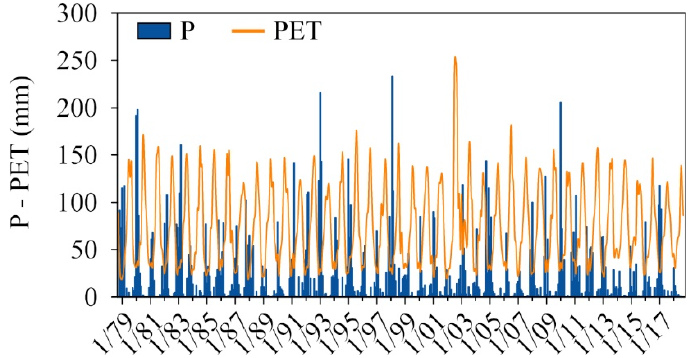
Figure 2. Monthly precipitation (P) and potential evapotranspiration (PET) from Agua Caliente (1979–2016) and Guadalupe Valley (2017–2018) weather stations, Baja California, Mexico. The x -axis indicates month/year. Table 1. Drought severity classification according to the Standardized Precipitation Index (SPI) modified from [7], applied to the classification of drought in the Guadalupe Valley Basin, Baja California, Mexico. Drought Classification SPI Normal (NOR) > − 0.5 Abnormally dry (AD) − 0.5 to − 0.8 Moderate drought (MD) − 0.8 to − 1.3 Severe drought (SD) − 1.3 to − 1.6 Extreme drought (ED) − 1.6 to − 2 Exceptional drought (ExD) < − 2